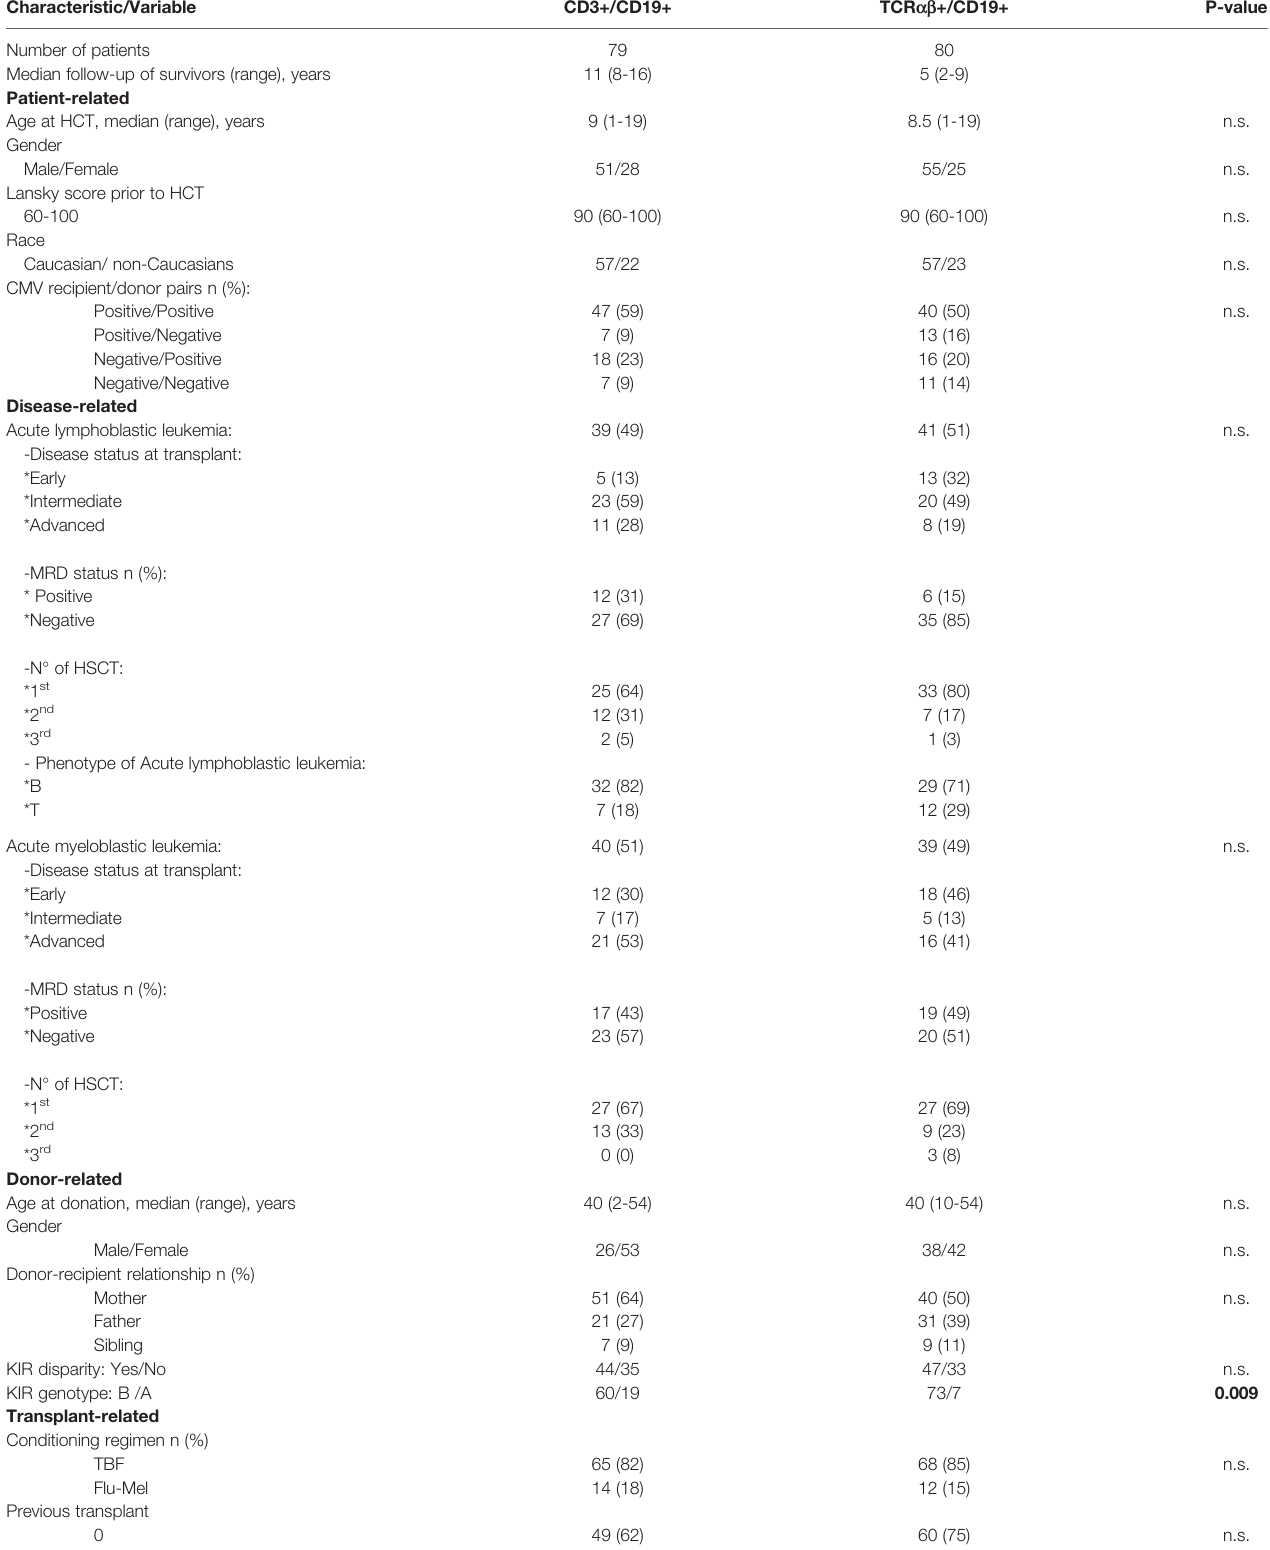
TABLE 1 | Patients, donors and transplant